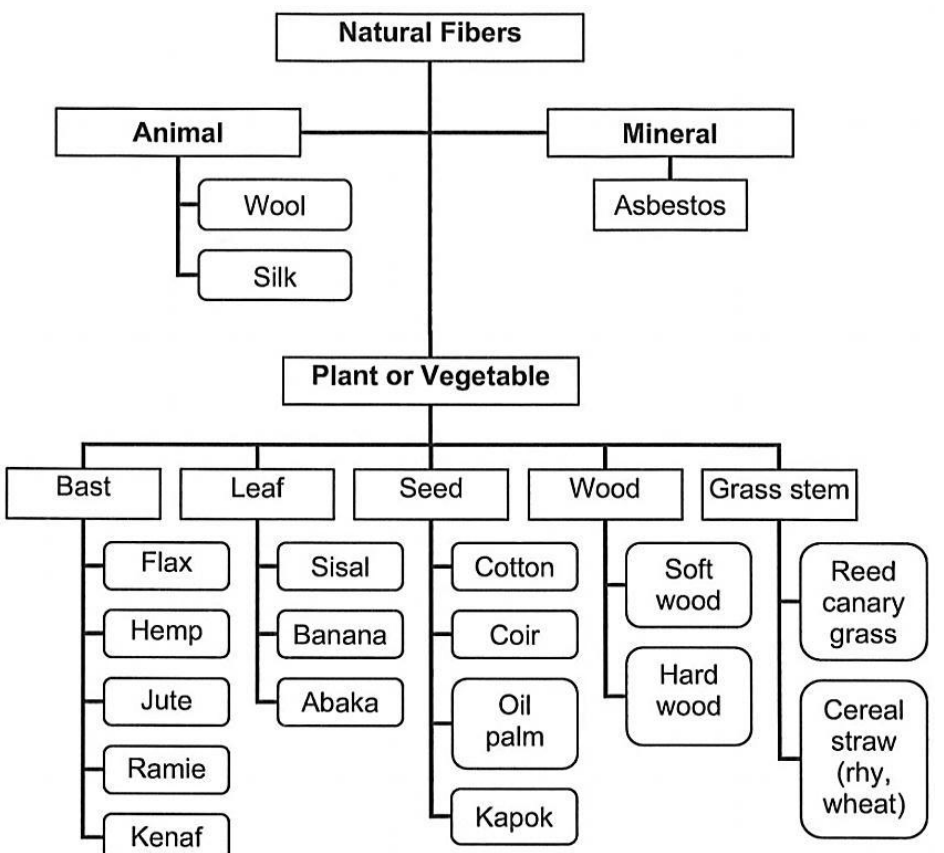
Figure 1. Classification of natural fibres according to origin.